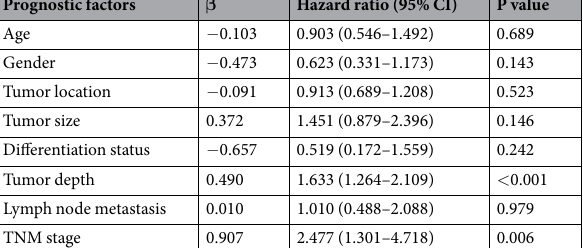
(Fig. 3, P = 0.102), and the prognosis of stage III gastric ASC was worse than that of stage III gastric AC (Fig. 3, P < 0.001).